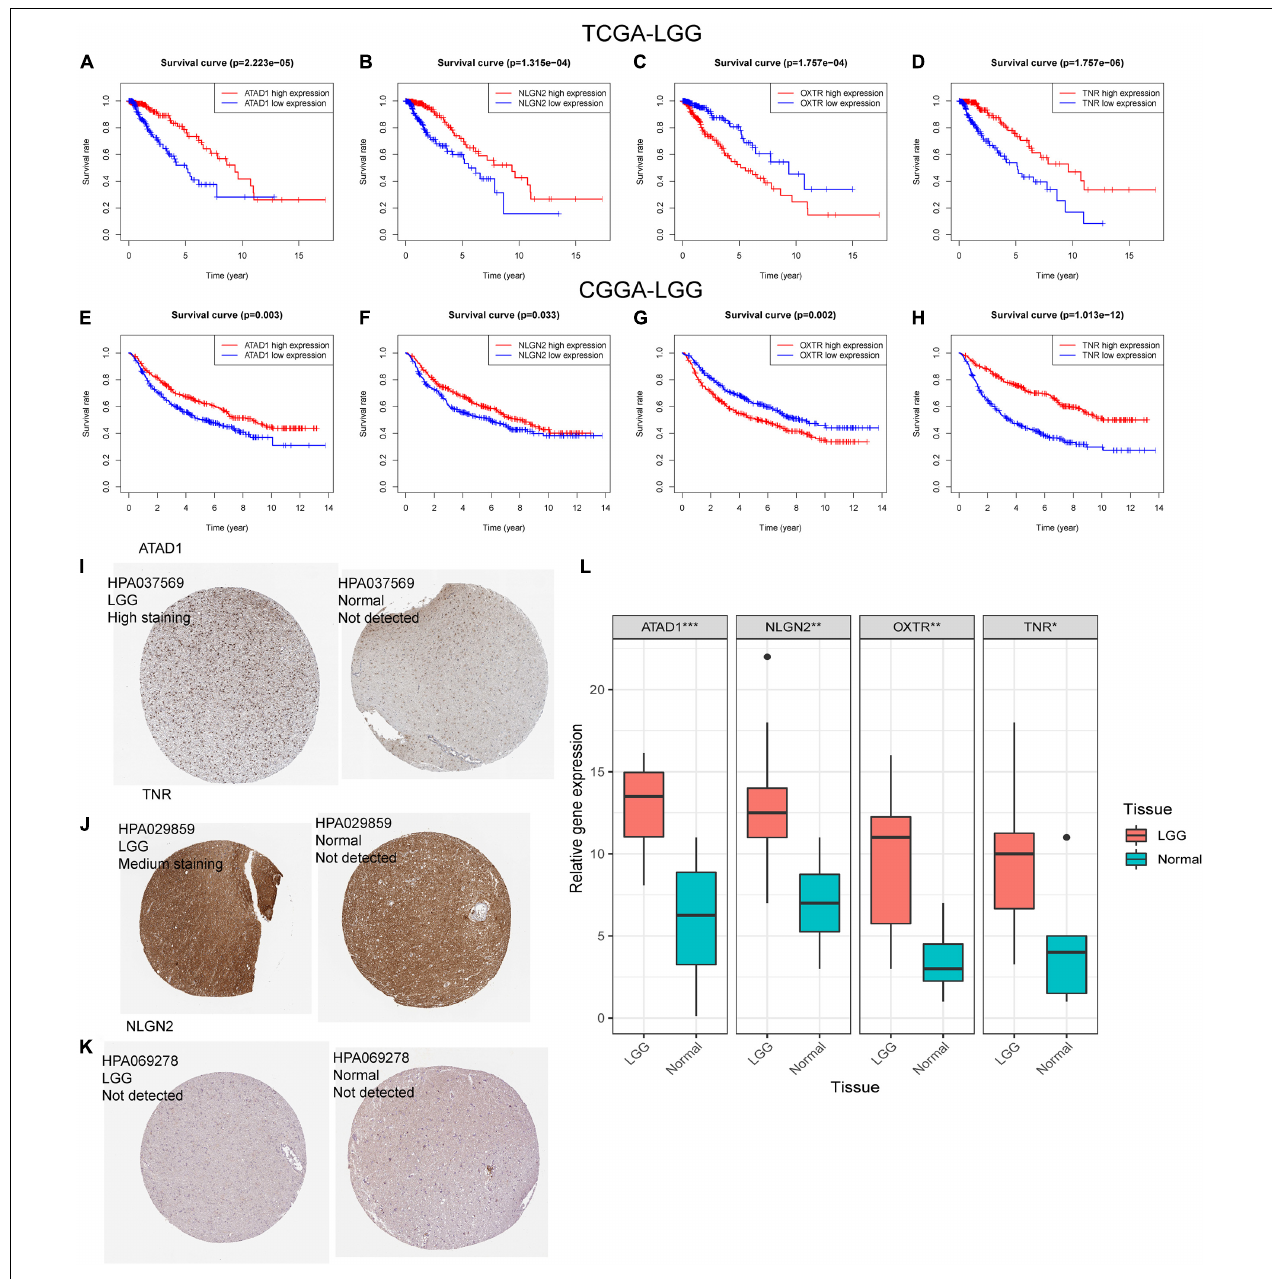
FIGURE 10 | Verification of the prognostic value and expression of hub genes of GSRS. Survival analysis of ATAD1, NLGN2, OXTR, and TNR for patients in TCGA (A–D) and CGGA (E–H) cohorts. The protein expression level of ATAD1 (I) , NLGN2 (K) , and TNR (J) in normal and LGG tissues according to the HPA database. (L) The relative mRNA expression levels of ATAD1, NLGN2, OXTR, and TNR are compared among LGG and non-tumor tissues based on real-time PCR results. *** p < 0.001, ** p < 0.01, * p <